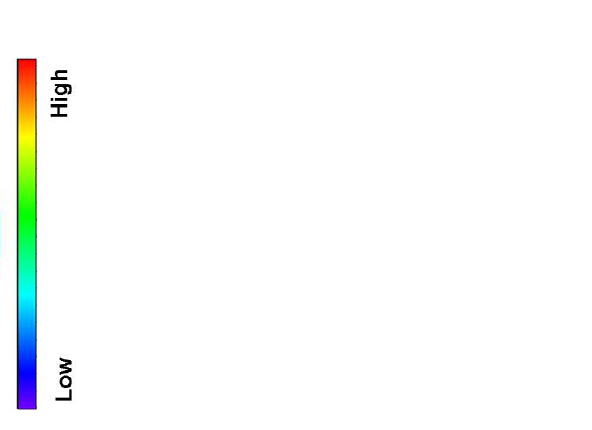
Figure 5. Paper disc assay showing the interaction of M21 with cefoxitin in isolate 14. Cefoxitin (4 mM, 5 µL) induced hla expression against different clinical isolates. M21 (4 mM, 5µL) repressed hla expression even in the induced state. Table 1. Interaction between M21 and cefoxitin in different isolates * .